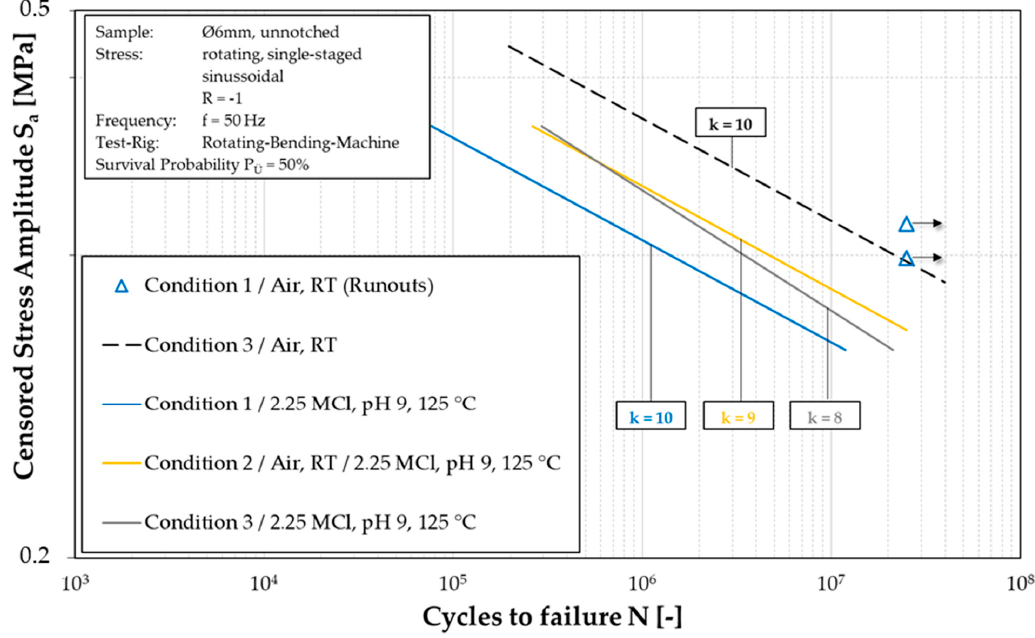
Figure 3. Results of fatigue and CF tests on alloy 718 represented using double logarithmic S/N curves (survival probability of 50%).